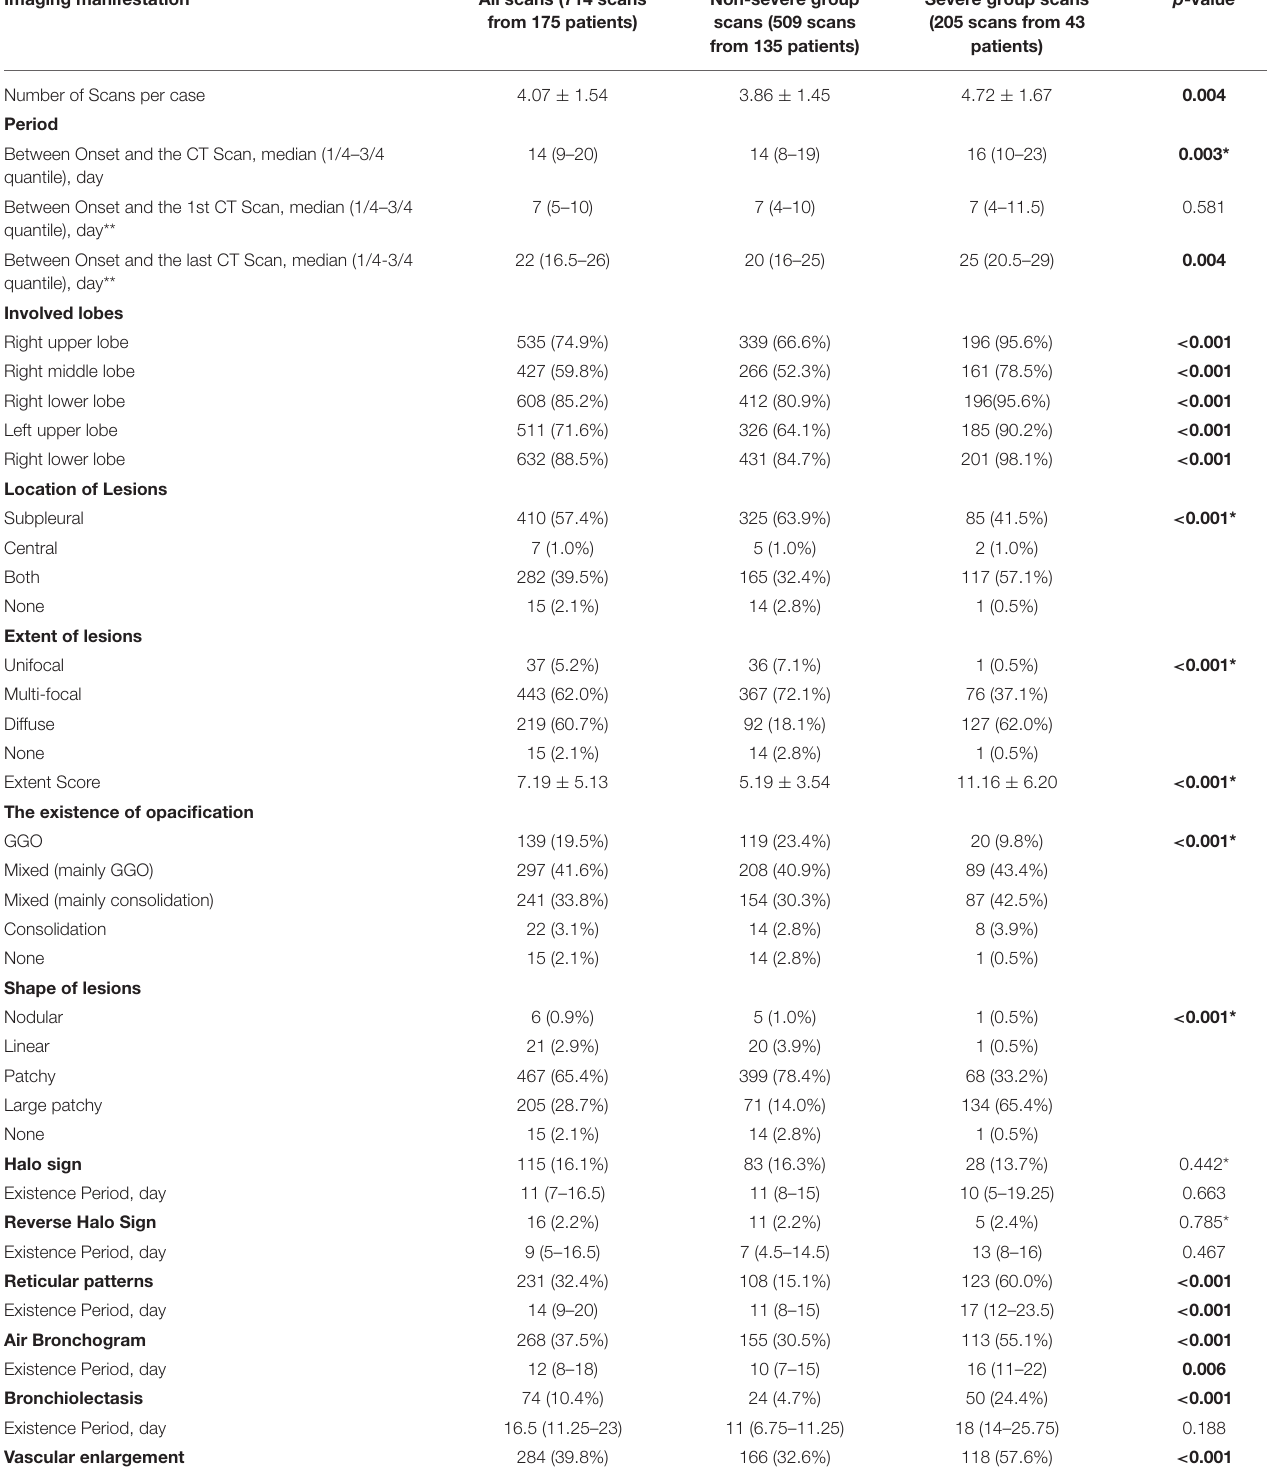
TABLE 2 | Chest CT imaging manifestations in non-severe and severe groups from onset to discharge. Imaging manifestation All scans (714 scans